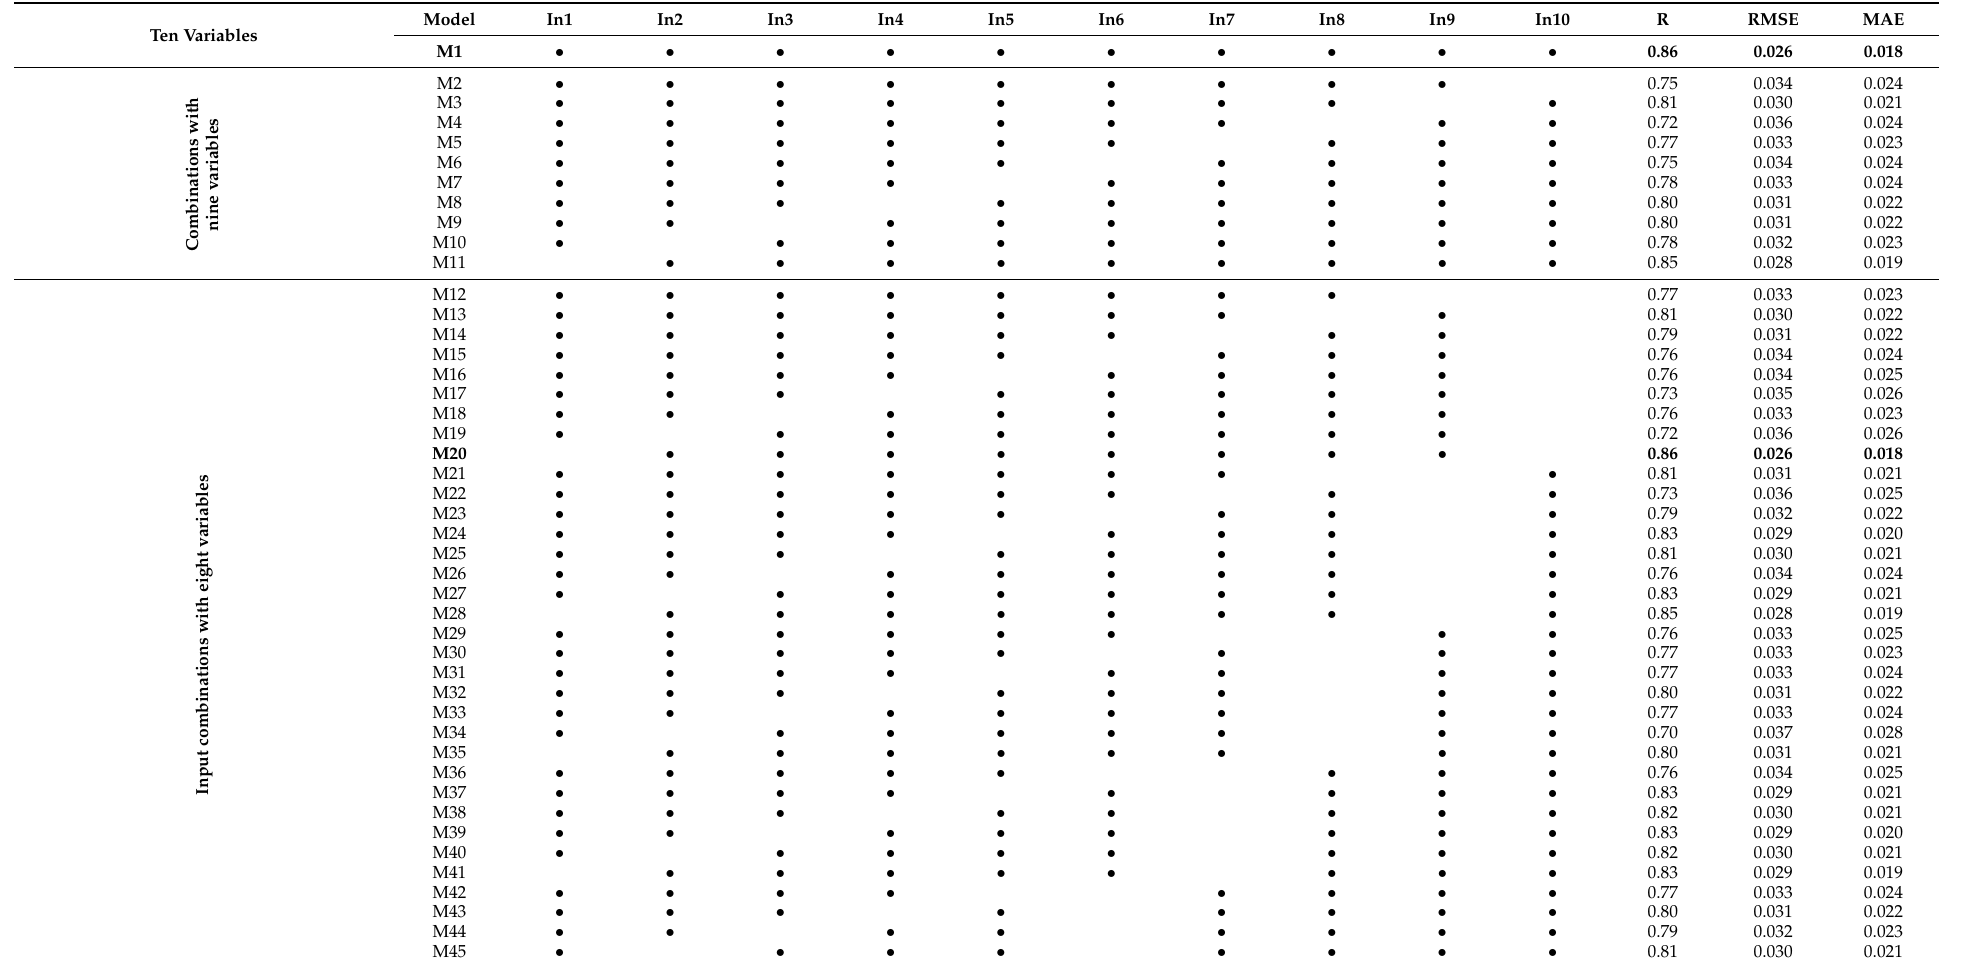
Table 3. Models in the systematic controllability variable reduction approach for nine and eight bone curvature region variables with their performance in predicting medial condyle cartilage volume loss at one